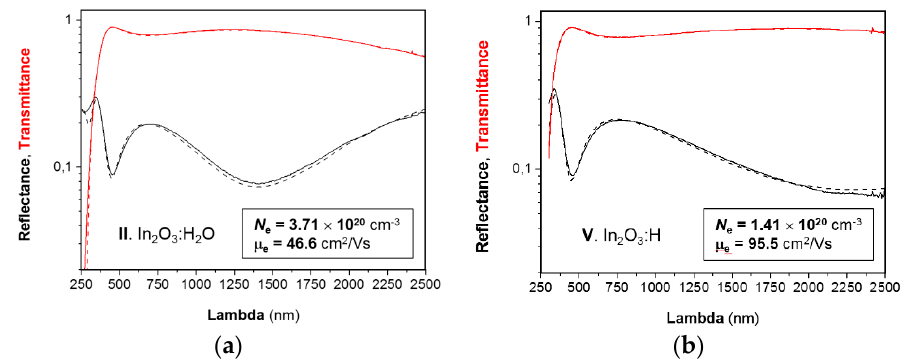
Figure 4. Fits (dashed lines) of the optical spectra (solid lines) for ~100 nm thick In 2 O 3 :H 2 O ( a ) and In 2 O 3 :H ( b ) films on glass. The µ e and N e values identified from the fitted spectra are given. Corresponding plasma edges, film thicknesses and mean square errors are as follows: ( a ) λ p = 916.918 nm, d = 103.385 nm, MSE = 0.00757124; ( b ) λ p = 1486.62 nm, d = 104.554 nm, MSE = 0.00893229.